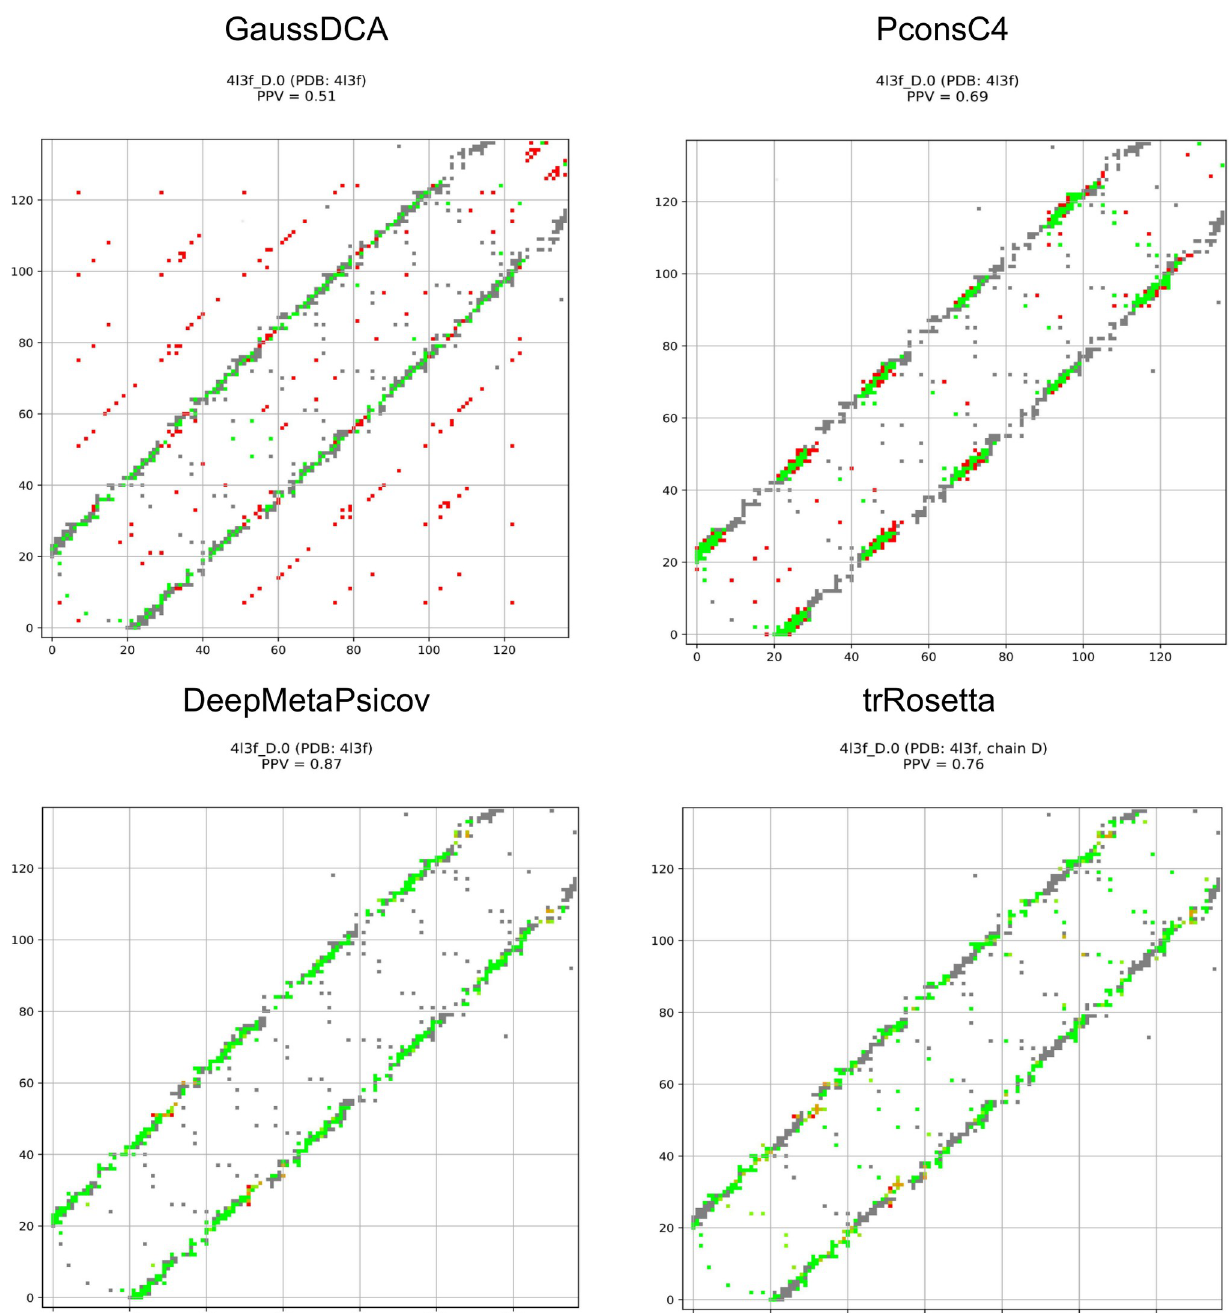
Fig 4. GaussDCA, PconsC4, DeepMetaPsicov, and trRosetta contact maps. Contact map for predictions obtained with GaussDCA, PconsC4, DeepMetaPsicov and trRosetta. In grey, the real contacts from the structure, in green, the corrected predicted contacts, and the falsely predicted contacts in